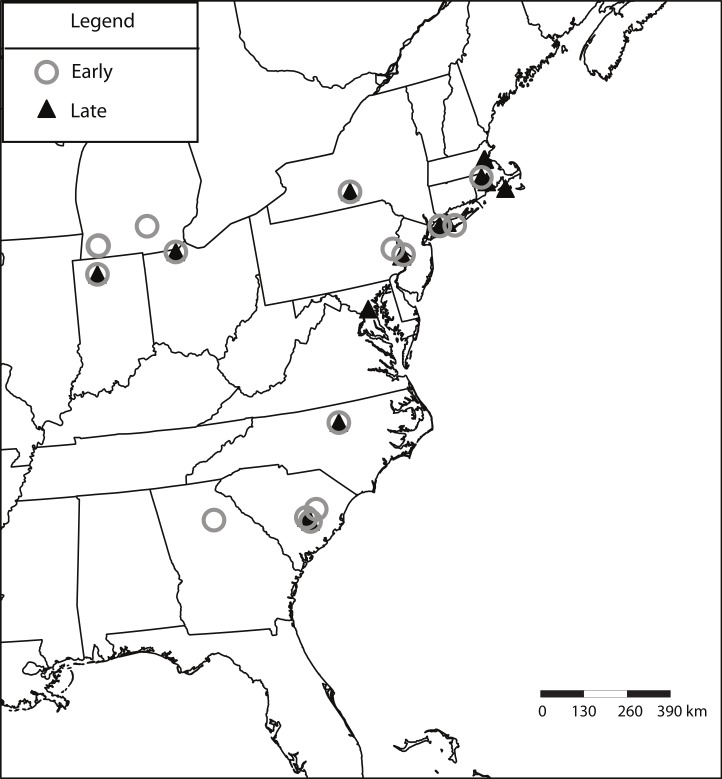
Map of origin sites of selected A. thaliana lines.Lines selected from the earliest flowering quintile are shown as grey circles, while lines selected from the latest flowering quintile are dark triangles.